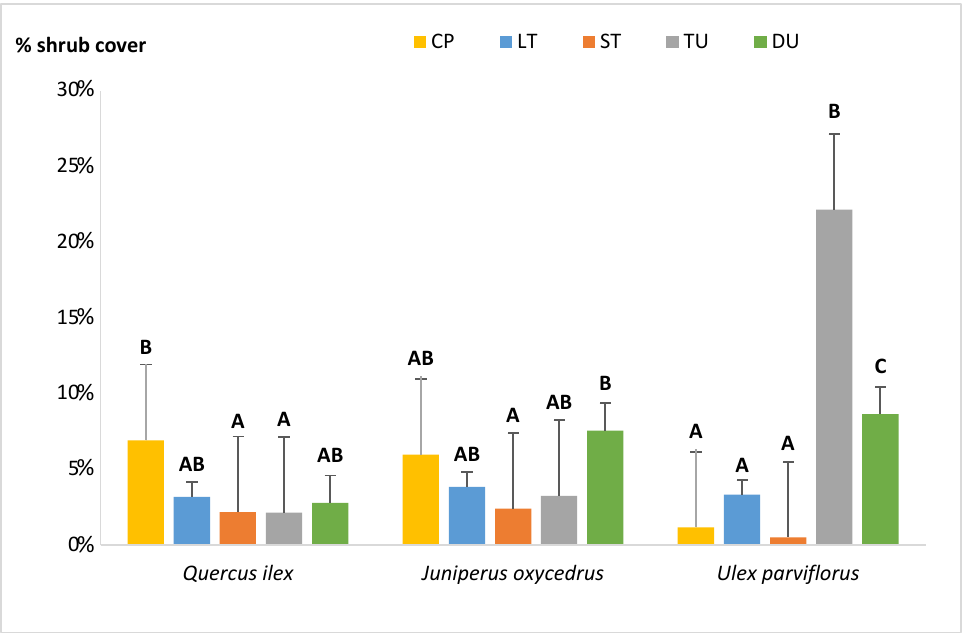
Figure 10. Average shrub cover percentage by species and treatment applied. The different letters indicate significant differences among treatments. There are no significant differences between a level with two letters and those of the corresponding single letters.